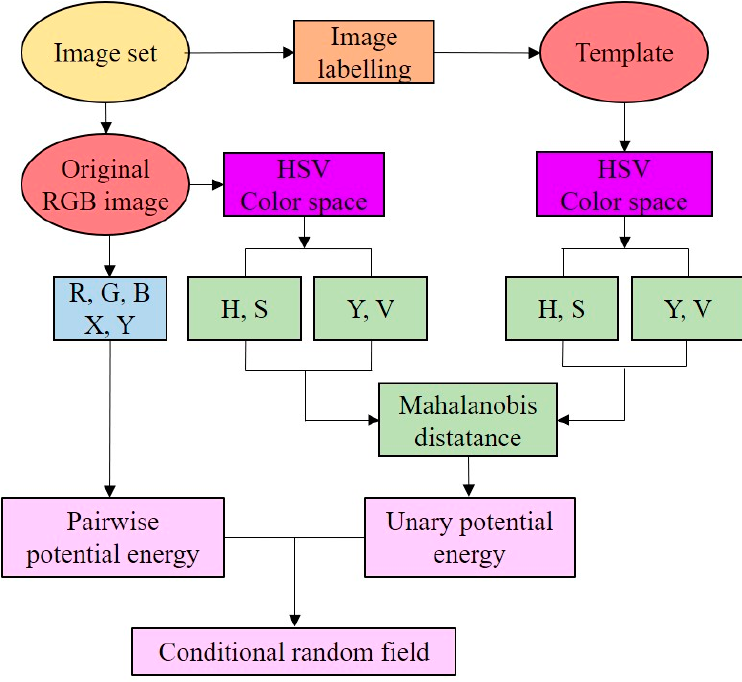
Figure 4. Overall flowchart of the proposed method.